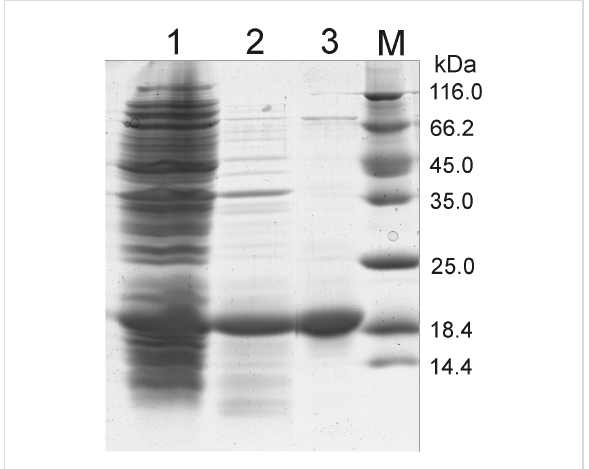
Figure 1: SDS-PAGE profile of α -SynC141 at different steps during purification. 1: cell-free extract; 2: cell-free extract after heating at 100 °C; 3: α -SynC141 protein after purification using Q XL and ANX columns; M: a molecular mass marker (unstained protein molecular weight marker (Thermo Scientific)). The positions of the molecular weight standards are indicated to the right (kDa).